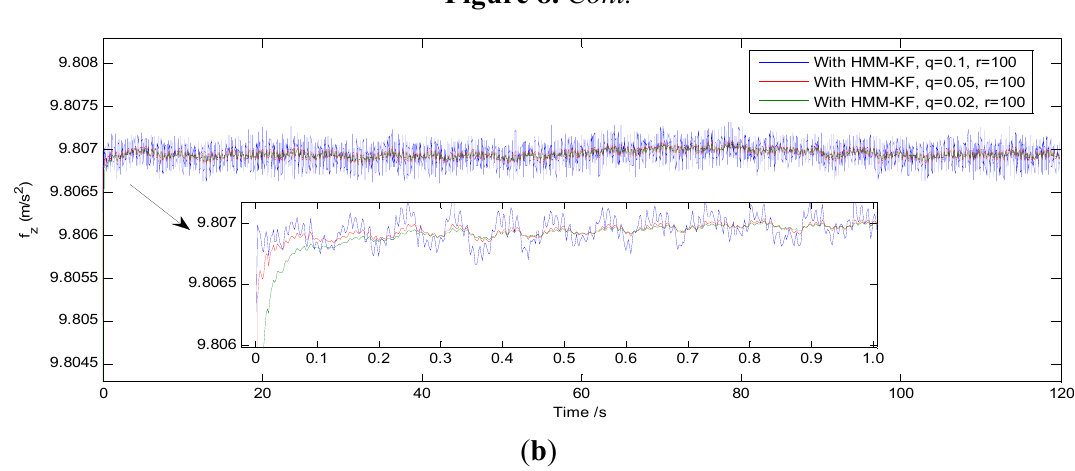
With HMM-KF, q=0.1, r=100 With HMM-KF, q=0.05, r=100 With HMM-KF, q=0.02,